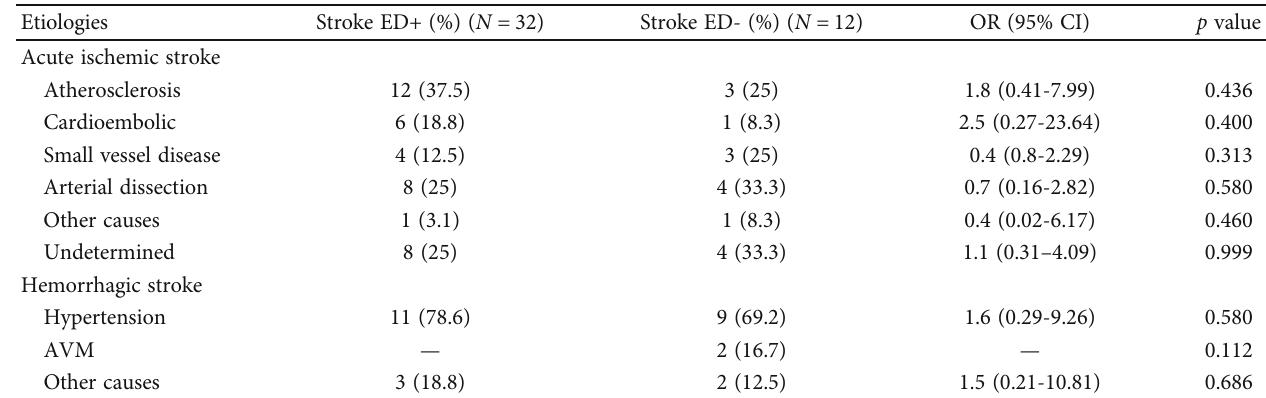
Table 4: Etiologies of acute ischemic stroke and hemorrhagic